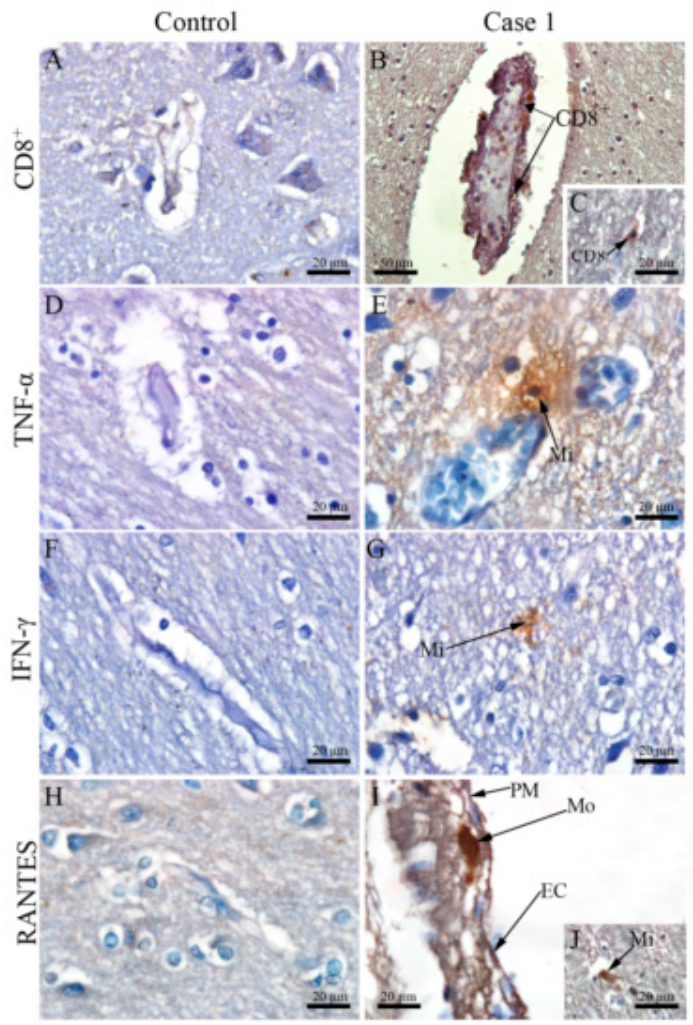
Figure 5. Detection of TCD8 + cells, cytokines and chemokine in brain tissue of fatal cases. ( A , D , F , H ) Brain tissue of a non-dengue case; ( B ) TCD8 + cells inside the capillaries and bordering them ( C ) and in the white atter; ( E ) TNF- α in microglial cells; ( G ) IFN- γ in microglial cells ( I ) RANTES in endothelial cells ( J ) and microglial cells. CD8—TCD8 + cells, Mi—Microglia, EC—Endothelial cells.